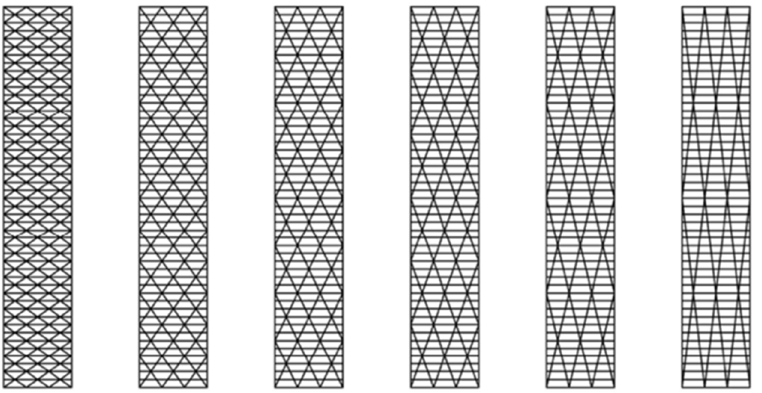
Figure 14. Variation in the bracing angles leads to different structural performance and diagrid expressions. (Sketch by K. Al-Kodmany; adapted from [23]).